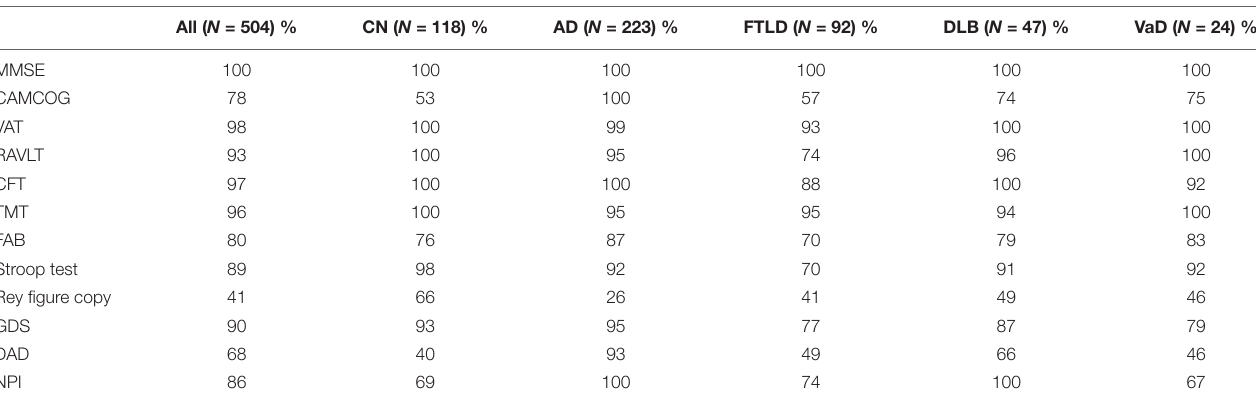
TABLE 2 | Proportions of patients for which the different neuropsychological tests were